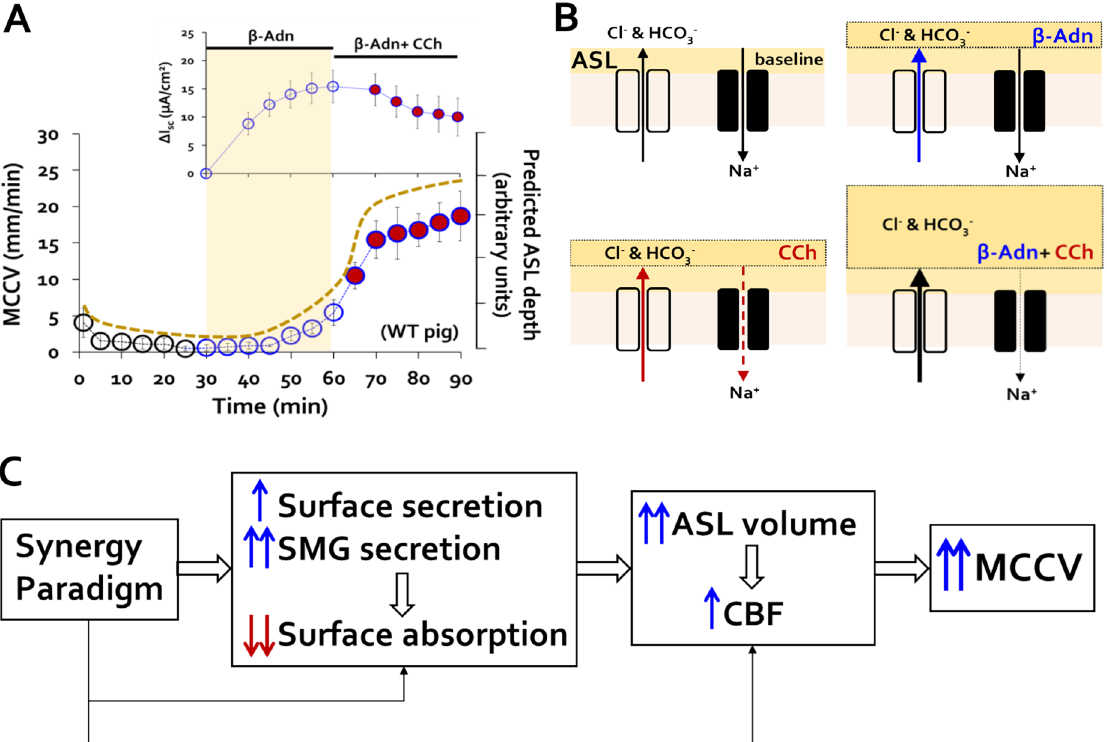
Figure 6. Summary diagram linking increased ASL to increased mucus clearance. ( A ) Relationship between ∆I sc , ASL depth and MCCV. MCCV (redrawn from Fig. 1C) is shown on the main graph; inset shows ∆I sc (from Fig. 4C) with time points aligned to the MCCV graph. Dashed brown line is inferred change in ASL depth in the absence of MCC. ( B ) Cartoons of main electrogenic ion flows across tracheal surface epithelium in four conditions: baseline, β-adrenergic (β-Adn), carbachol (CCh), and β-Adn + CCh. Each panel shows the inferred status of anion secretion, Na + -absorption and resulting changes in ASL depth. The depth of ASL depth is inferred. Because carbachol inhibits Na + (and fluid) absorption and stimulates anion (and fluid) secretion, the combined agonists have opposite effects on I sc , but at least additive increases ASL depth. ( C ) Summary diagram of component processes leading to synergistic increases in MCCV in ex vivo tracheas of WT ferrets, WT pigs and CF ferrets. The net result is a marked increase in